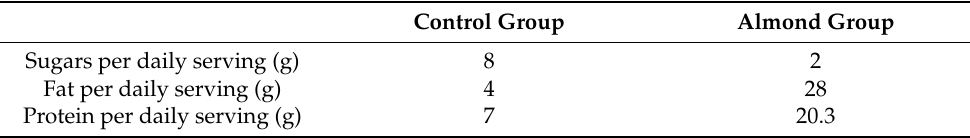
Table 3. Daily sugars, fat, and protein content of control and almond group supplementation. Control Group Almond